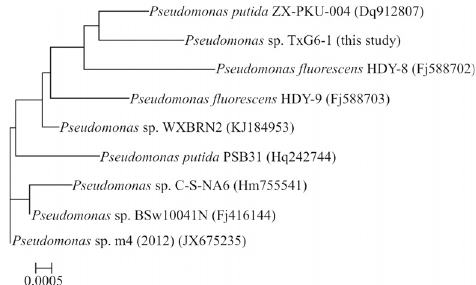
Figure 1 - Rooted neighbor-joining distance matrix tree derived from the 16S rRNA gene sequences of TXG6-1 and related bacterial. Accession numbers for the 16S rRNA gene sequences used are given in parentheses after the species and strain names. The scale bar represents a 0.05% nucle- otide substitution rate based on Kimura’s two-parameter